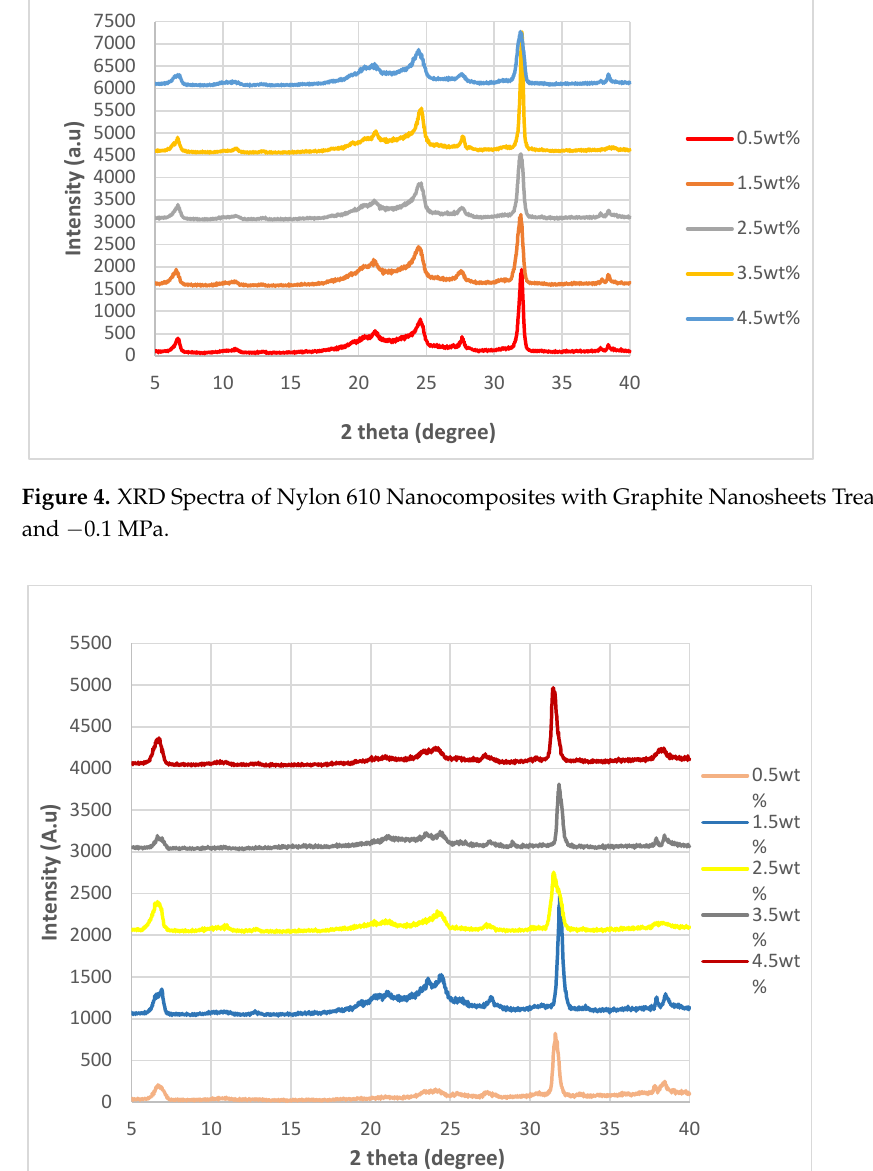
Figure 5. XRD Spectra of Nylon 610 Nanocomposites with Graphite Nanosheets Treated at 175 °C and − 0.1 MPa.